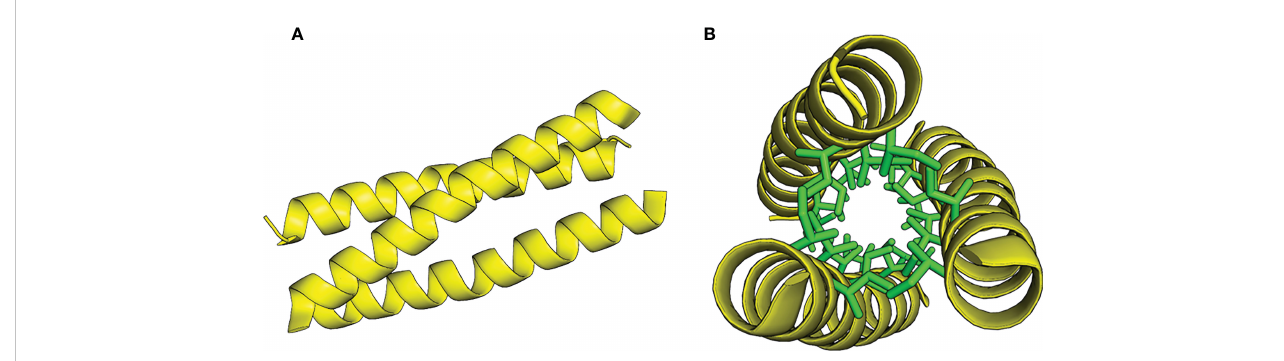
FIGURE 1 Model of the GCN4-pII coiled-coil trimer structure, adapted from PDB 2YO0 (Hartmann et al., 2012). (A) Side view. (B) Top view with core isoleucins in a and d positions represented as stick models, colored